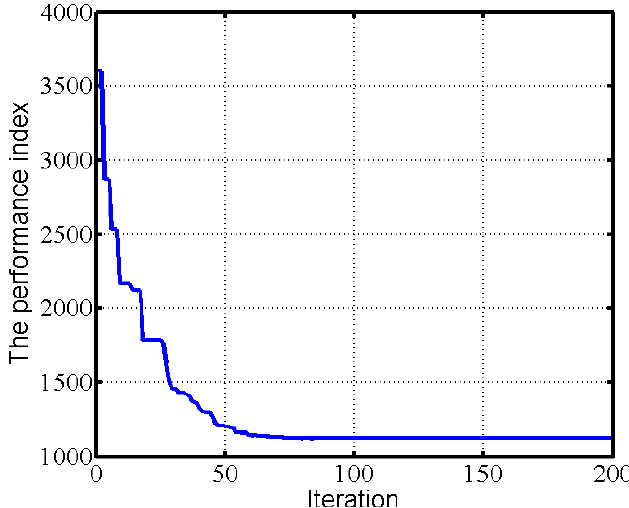
Figure 8. Evolutionary curve of the performance index. The comparison of the output value from the identification system and the true value from the experiment is shown in Figure 9.